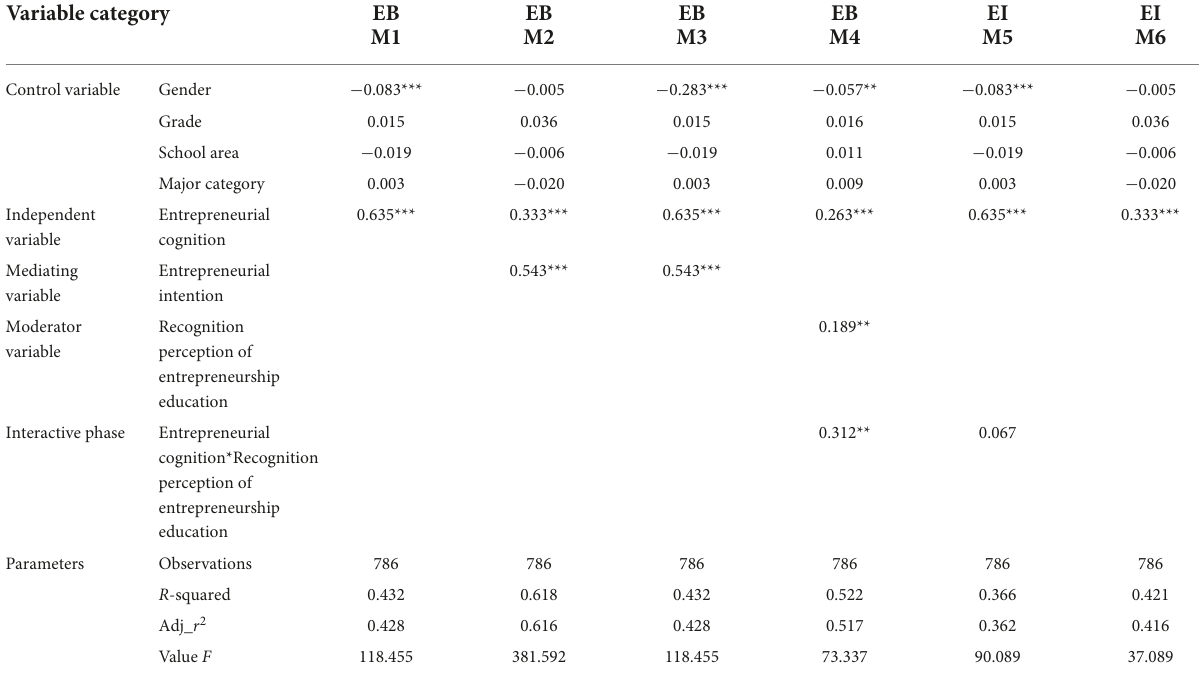
TABLE 5 Hypotheses testing